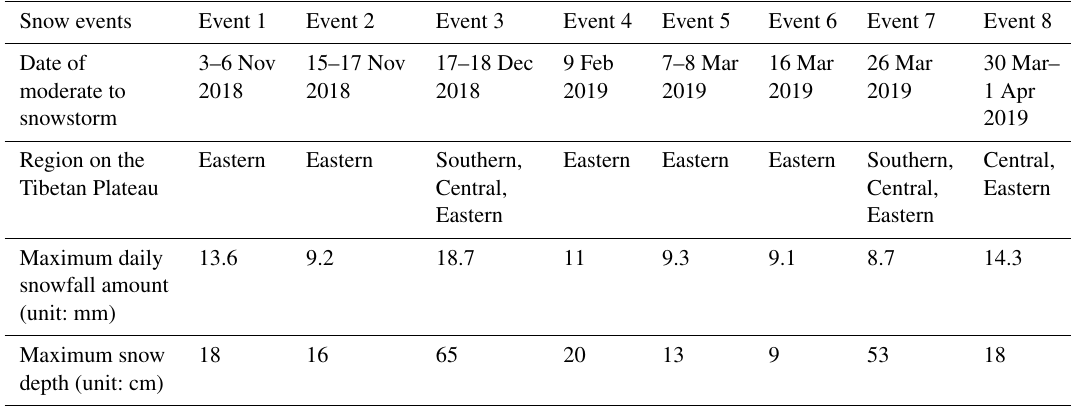
Table 1. Description of eight snowfall events using China Meteorological Administration observations. Snow events Event